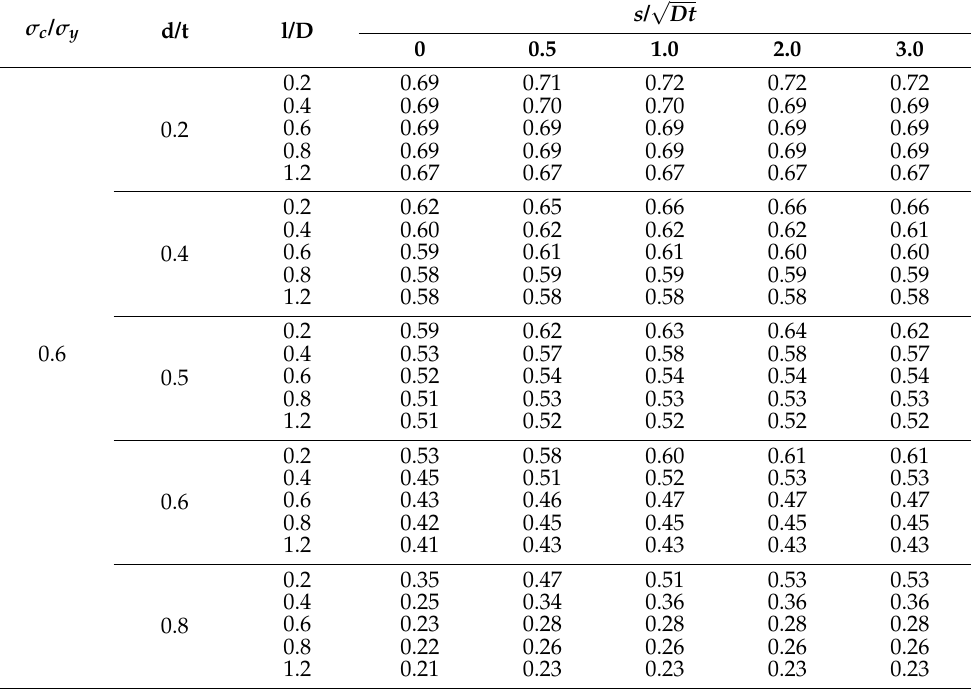
Table 9. FEA on corroded pipeline with LID subjected to internal pressure and 0.6 σ c / σ y longitudinal compressive